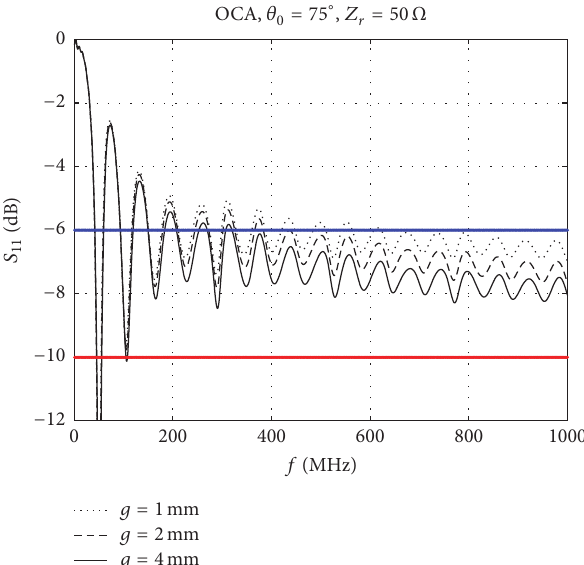
Figure 28: 𝑓 𝐻 /𝑓 𝐿 × 𝜃 0 chart for the OCA for 3 different gap lengths and 𝑍 𝑟 = 50 Ω